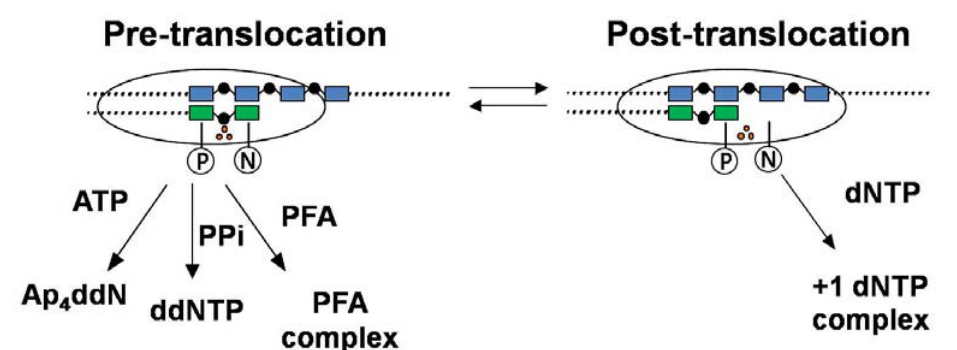
Figure 3. Positioning of RT with respect to the 3’-end of the primer. The pre-translocation complex places the RT active site in position to carry out excision with ATP or PPi as acceptor substrate. The primer terminus occupies the dNTP-binding site (N site) on RT. RT is stabilized in this position by binding PFA. The post-translocated complex places the RT in a position to add the next deoxynucleotide. The primer terminus occupies the primer- binding site (P site) on RT. RT is stabilized in this position by binding the next complementary dNTP [38,45–47,87]. The template and primer are shown in blue and green, respectively. The three orange dots correspond to active site catalytic residues, which are located near the boundary between the N and P